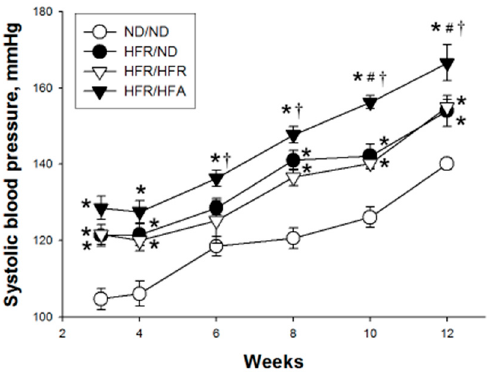
Figure 1. Effect of maternal and post-weaning high-fructose (HFR) and post-weaning high-fat (HFA) intake on systolic blood pressure in 12-week-old male offspring. * p < 0.05 vs. ND/ND; # p < 0.05 vs. HFR/ND; † p < 0.05 vs. HFR/HFR.